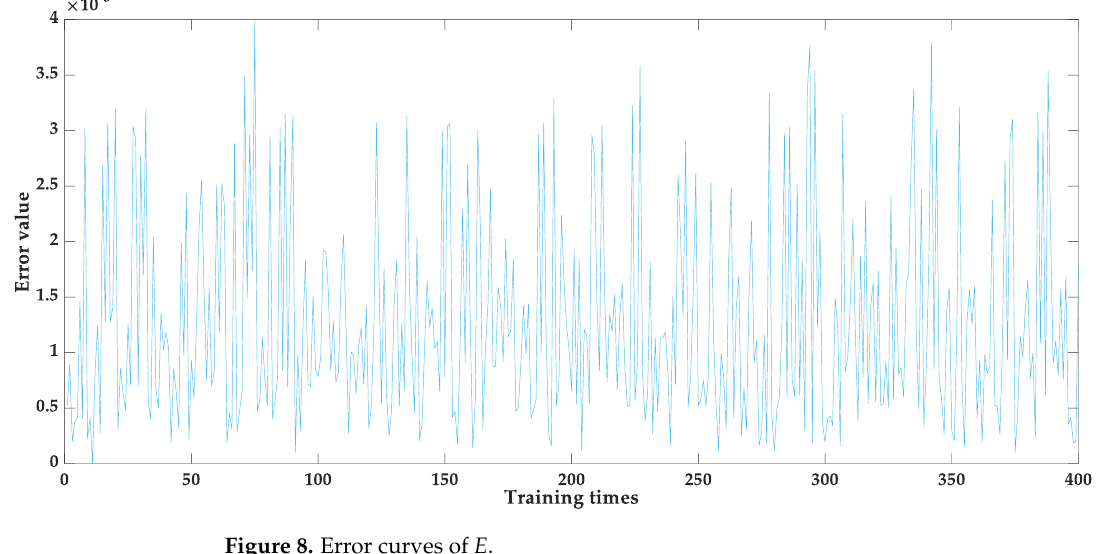
Figure 8. Error curves of E .